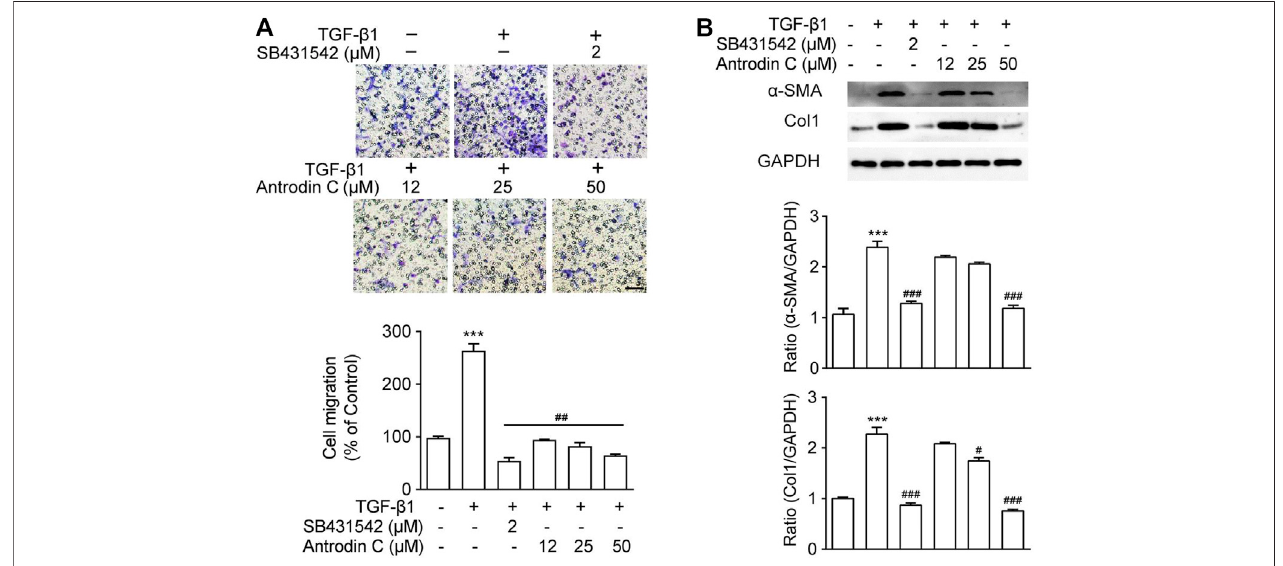
FIGURE2| EffectsofAntrodinConTGF- β 1inducedcellmigrationaswellas α -SMAandCol1productioninCFSC-8Bcells. (A) Representativeimagesofmigrated CSFC-8Bcellstreated withorwithoutAntrodinC(12 – 50 μ M) and SB431542 inthepresence orabsenceofTGF- β 1.Thedatawere normalized to%ofmigrated control